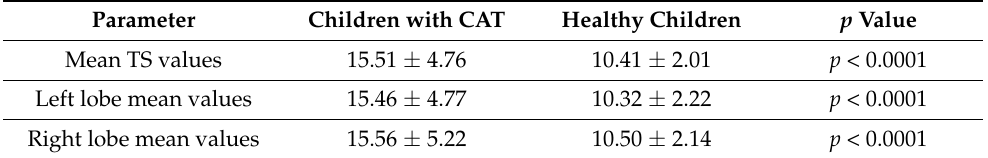
Table 2. Mean thyroid stiffness values in the two children groups (values are expressed in kPa ± SD).